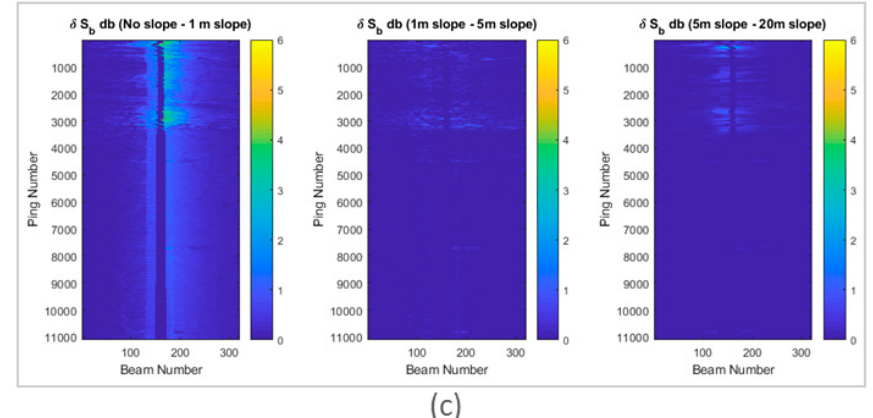
Figure 16. ( a ) Comparison of incidence angle from one beam (#50) showing results with no slope correction compared to slope corrections using a bathymetric grid of a 1, 5, and 20 m spatial resolution. ( b ) Di ff erences (absolute) in the incidence angle as computed with no slope correction and using a 1 m spatial resolution grid; 1 and 5 m grid resolution; and 5 and 20 m grid resolution. ( c ) Di ff erences (absolute) in processed backscatter results computed with no slope correction and using a 1 m spatial resolution grid; 1 and 5 m grid resolution; and 5 and 20 m grid resolution.